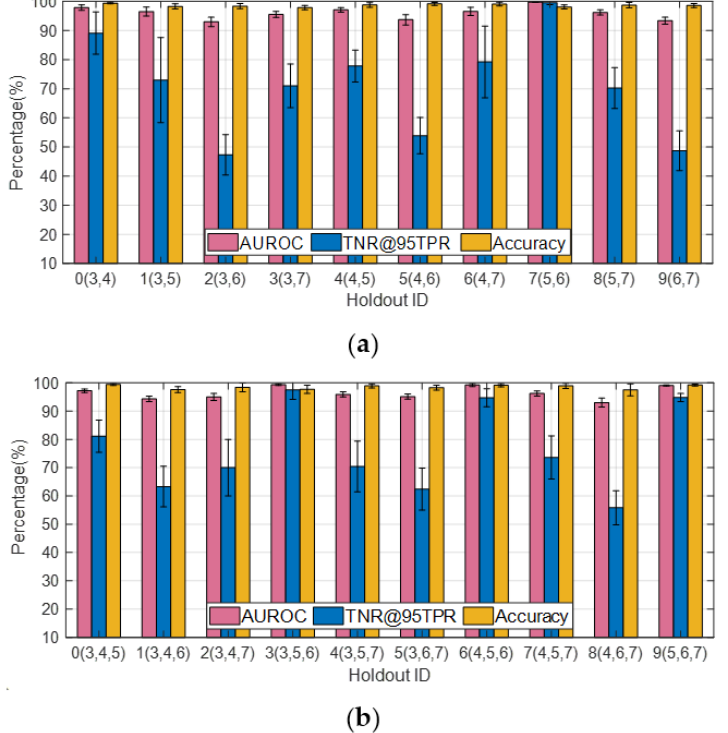
Figure 11. Effect of holdout class choice on detection statistics ( K = 0.1). ( a ) J = 2; ( b ) J = 3.